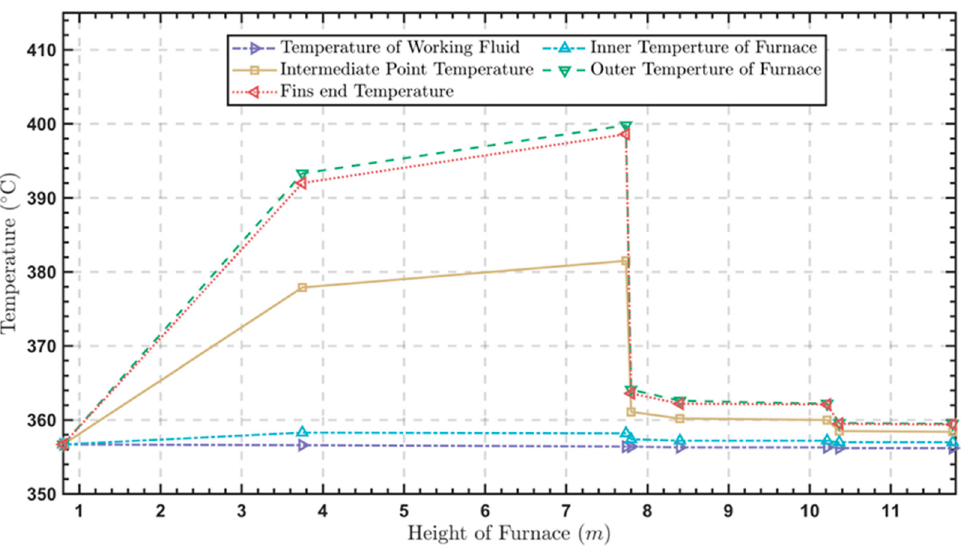
Figure 17. Wall temperature distribution of #135 circuit in upper furnace.